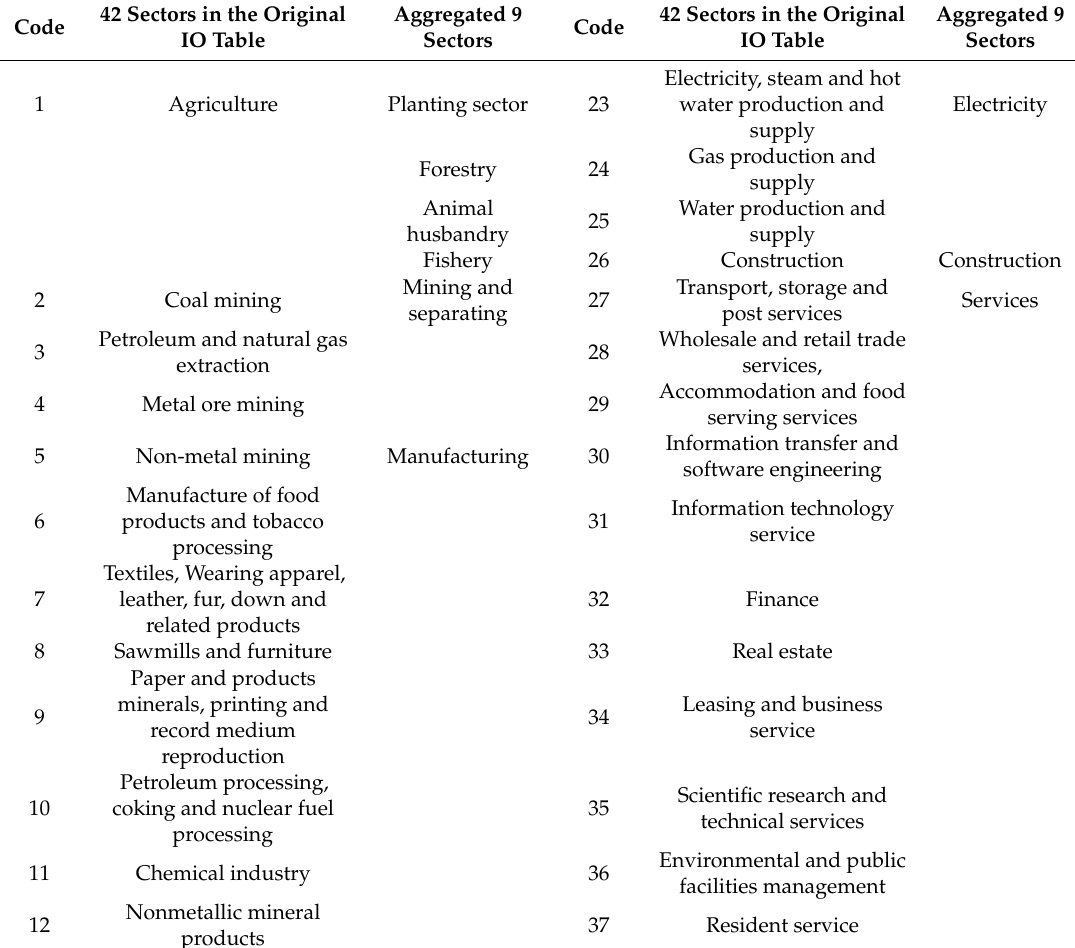
Table A1. Compilation of economic sectors in the socio-economic